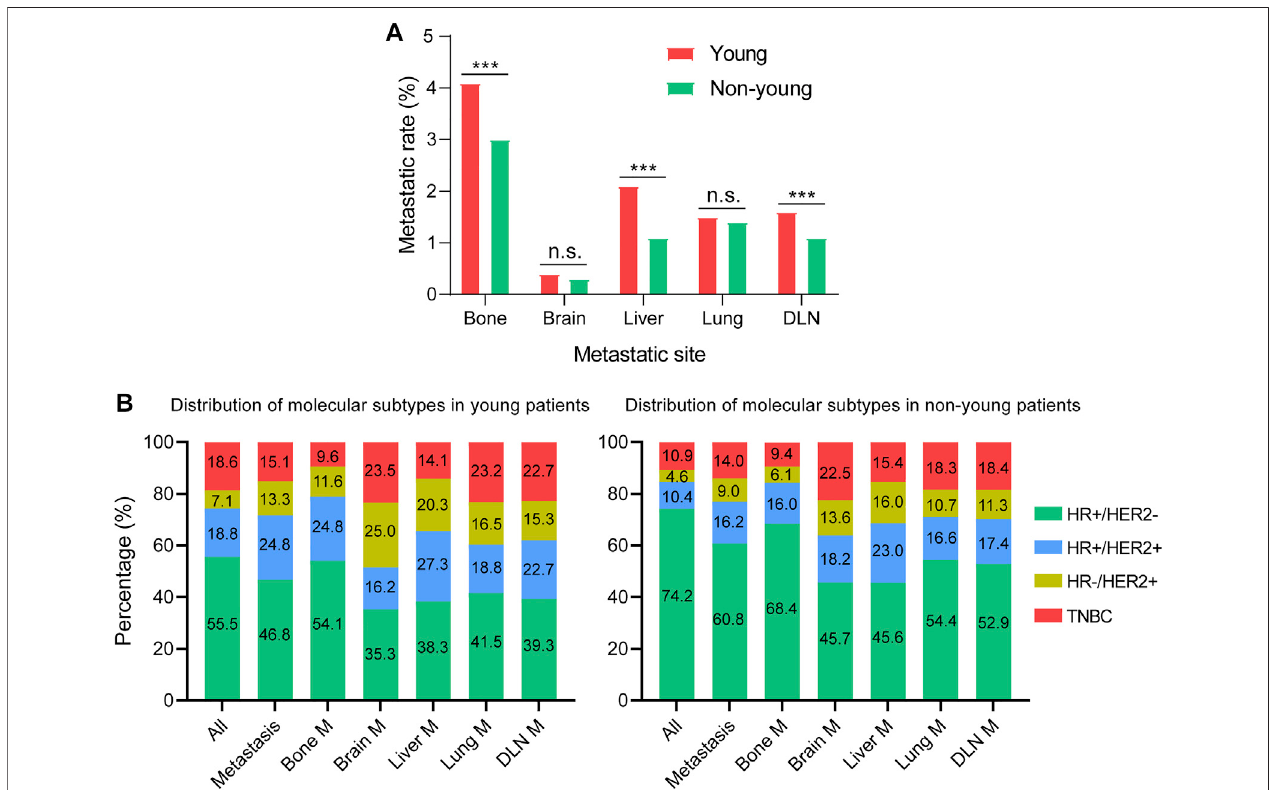
FIGURE2| Metastaticpatternsofyoungandnon-youngcohorts. (A) Comparisonoftheratesofdifferentmetastaticsites. (B) Distributionofmolecularsubtypesin different metastatic cohorts. *** p < 0.001; n.s., no signi fi cance. HR, hormone receptor; HER2, human epidermal growth factor receptor 2; TNBC, triple negative breast cancer; M, metastasis; DLN, distant lymph